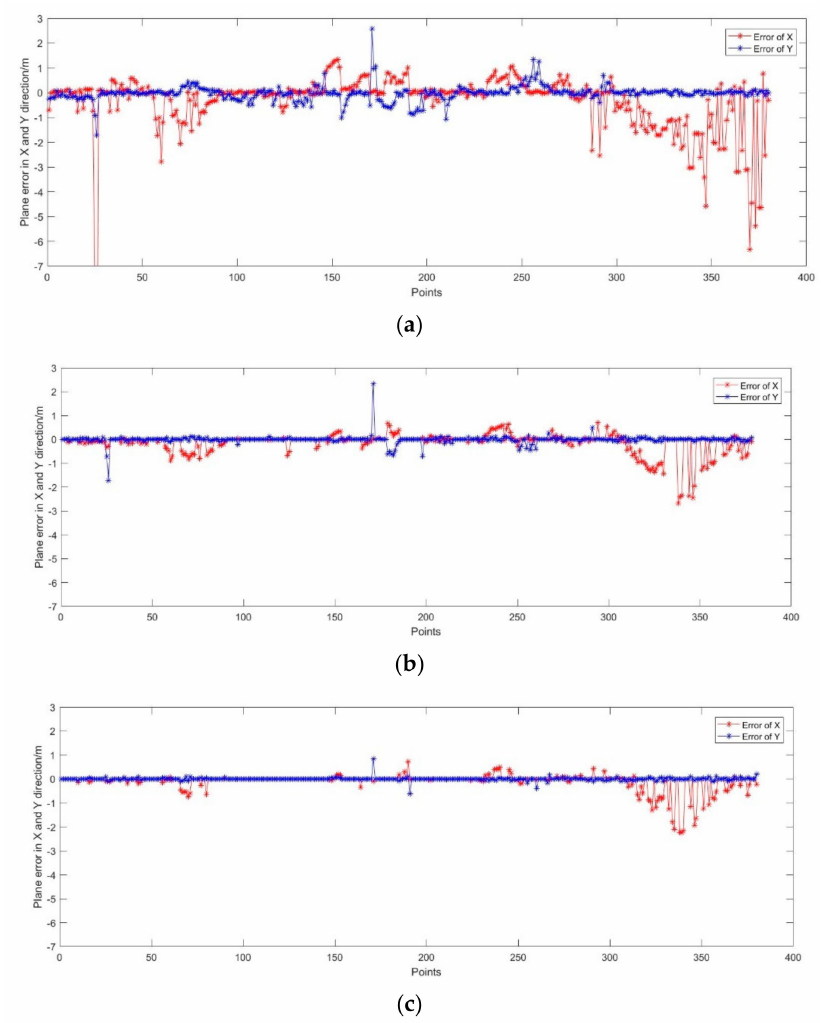
Figure 14. Plane error calculated based on three filtering algorithm. ( a ) Plane error calculated based on least square algorithm; ( b ) Plane error calculated based on Extended Kalman Filter (EKF) algorithm; ( c ) Plane error calculated based on Robust-EKF